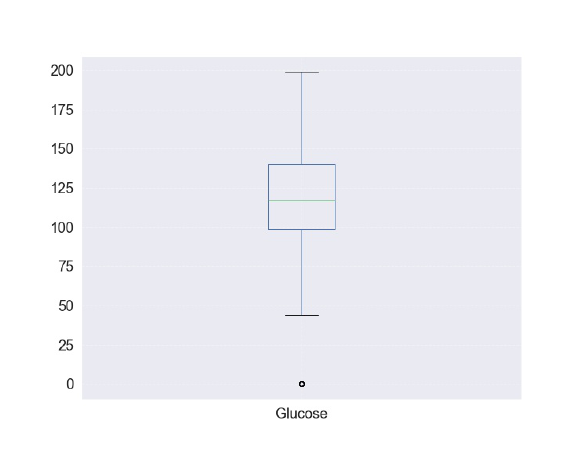
Figure 10. Box Plot for Attribute ‘Glucose’ in PID Dataset